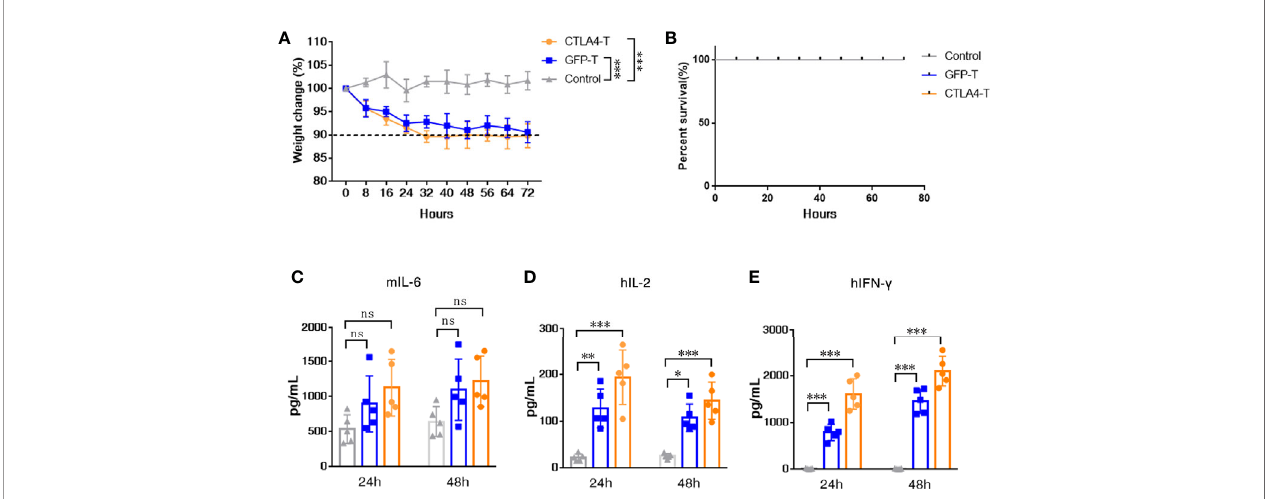
FIGURE 5 | CTLA4-chimeric T cells elicited mild CRS in vivo . (A) Weight change of tumor-bearing mice (n = 5) after T cell transfer, two-way ANOVA with Tukey ’ s multiple comparison test. (B) Percent survival of mice after CAR T cell transfer (n=5 mice for each group). (C – E) Serum levels of mIL-6, hIL-2, and hIFN- g 24 and 48 h post CAR T cell transfer were measured by ELISA. Signi fi cance values: * P < 0.05; ** P < 0.01; *** P < 0.001; ns, non-signi fi